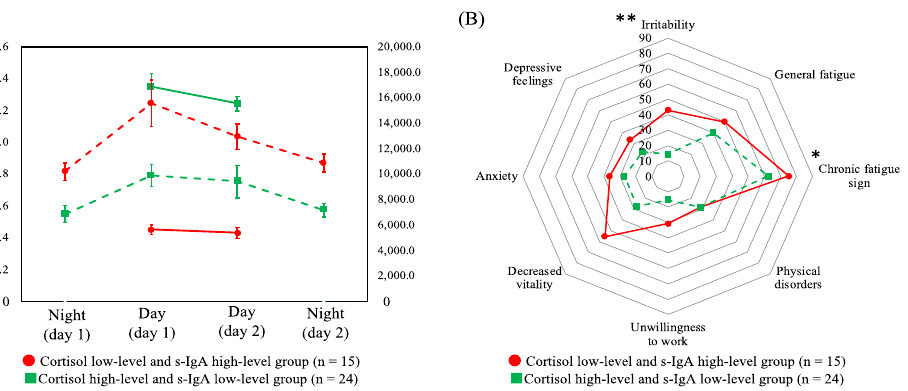
Figure 3. ( A ) Dynamics of cortisol levels across two day shifts (solid line) and secretory immuno- globulin A levels (dashed line) across four shifts of profiles of both combined biomarkers with means and standard errors. ( B ) Comparison of the median complaint rate (%) of the Cumulative Fatigue Symptom Index between profiles. Abbreviations: s-IgA = secretory immunoglobulin A. Note: * p < 0.050, ** p < 0.010.